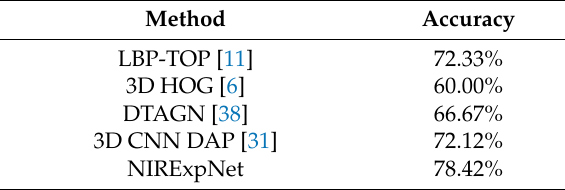
Table 4. Comparisons between our approach and state-of-the-art methods.